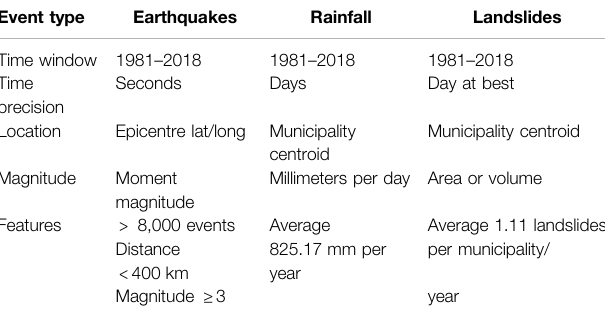
TABLE 1 | Description of the datasets